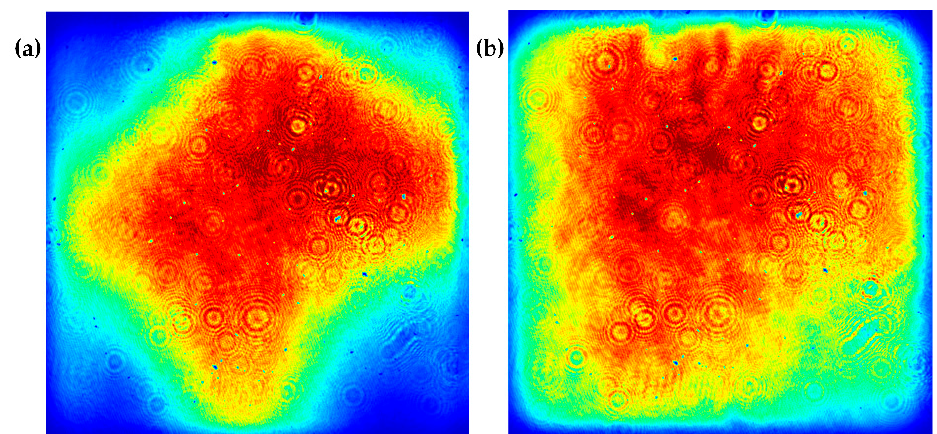
Figure 7. The near fields of a two ‐ pass laser. ( a ) No depolarization compensation; ( b ) with depolarization compensation.